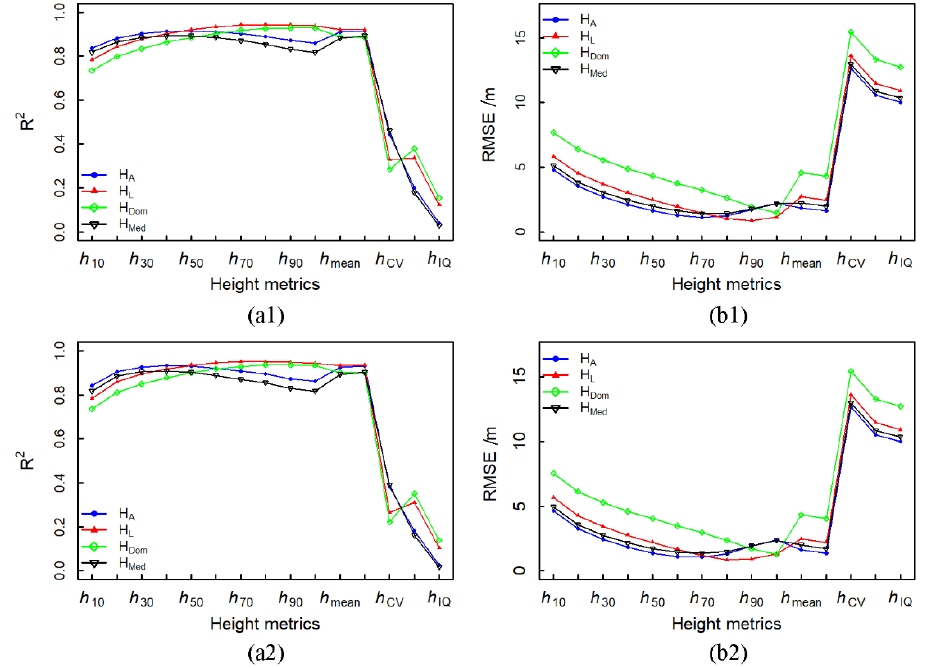
Figure 7. Correlation between the stand heights and height metrics calculated from the L-NPC metrics ( a1 , b1 ) and L-CHM metrics ( a2 , b2 ) for ALL plots.